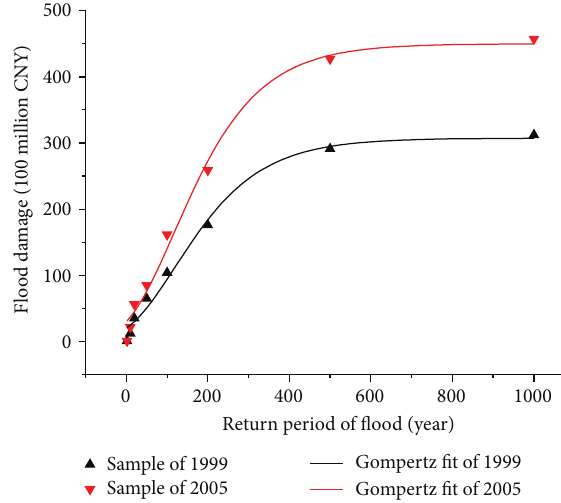
Figure 7: Gompertz function fitting results in 1999 and